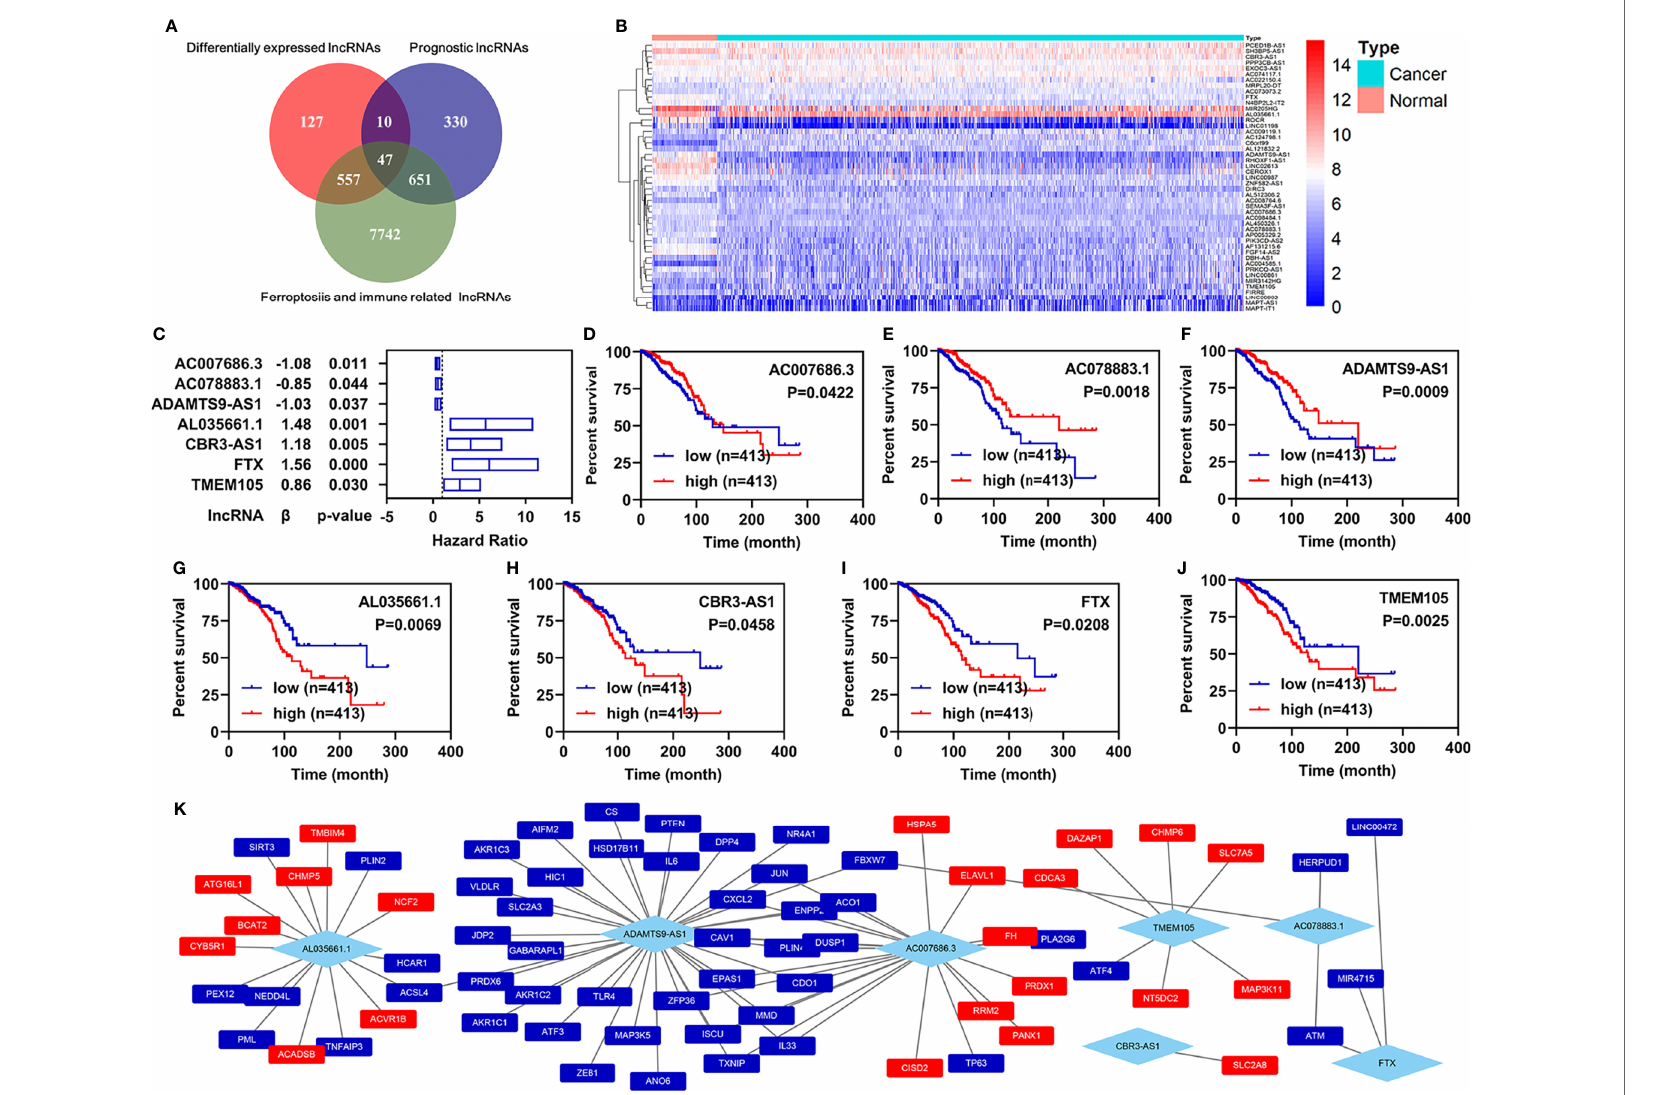
FIGURE 1 | Identi fi cation of ferroptosis- and immune-related lncRNAs as biomarkers. (A) Venn diagram to identify the common lncRNAs of differentially expressed lncRNAs, ferroptosis- and immune-related lncRNAs, and prognostic lncRNAs. (B) Heatmap of 47 common lncRNAs identi fi ed by Venn analyses. (C) Multivariate Cox regression analyses illustrated that seven FI-DELs were correlated with the OS of patients with breast in fi ltrating duct and lobular carcinoma independently. (D – J) Overall survival curve of these seven FI-DELs. (K) The correlation of these seven FI-DELs with the